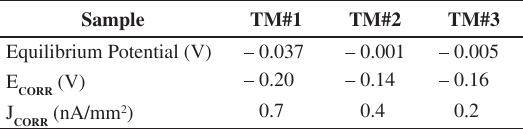
Table 3. Corrosion potential and corrosion rate for Ti-9Mo with three different oxygen contents. Sample